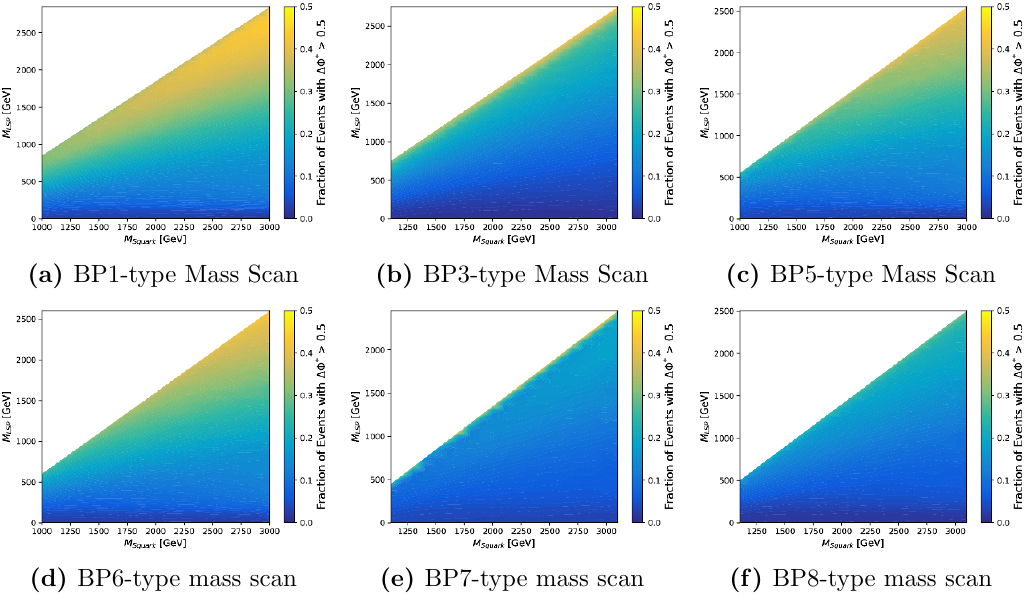
Figure 14. Fraction of events with (cid:1) (cid:30) (cid:3) > 0 : 5 for the BP1-BP8-type mass